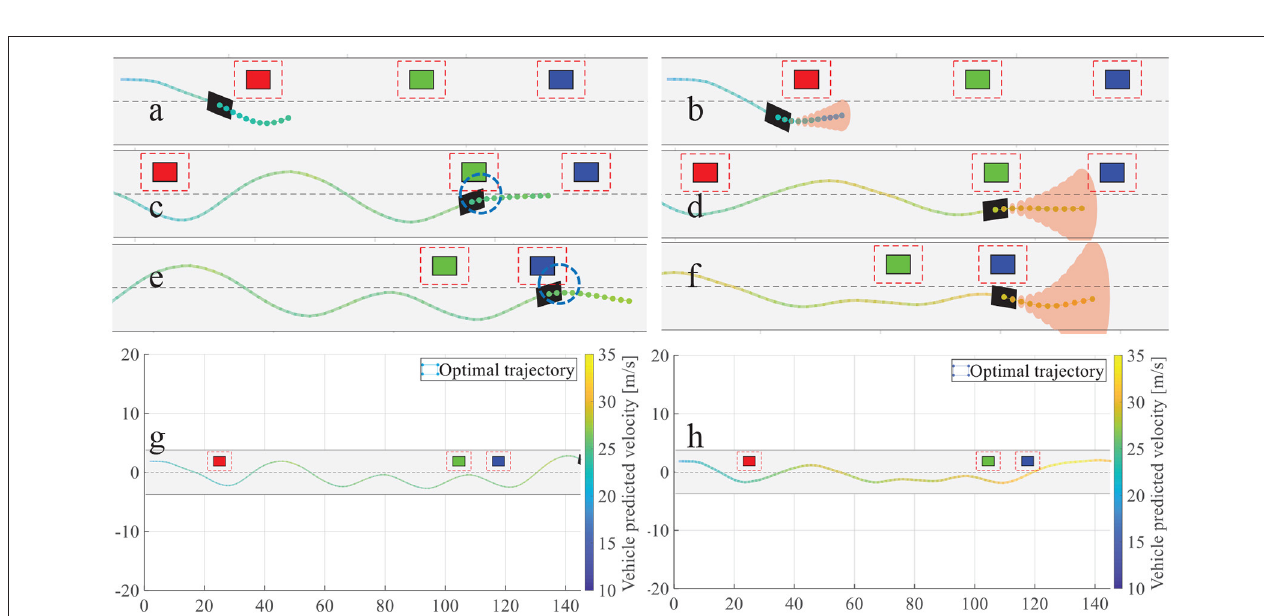
FIGURE 22 | Overtaking maneuvers and the overall driven trajectories. (a) Overtaking the first vehicle by NMPC; (b) Overtaking the first vehicle by GPMPC; (c) Overtaking the second vehicle by NMPC; (d) Overtaking the second vehicle by GPMPC; (e) Overtaking the third vehicle by NMPC; (f) Overtaking the third vehicle by GPMPC (g) Overall driven trajectories of NMPC; (h) Overall driven trajectories of GPMPC.